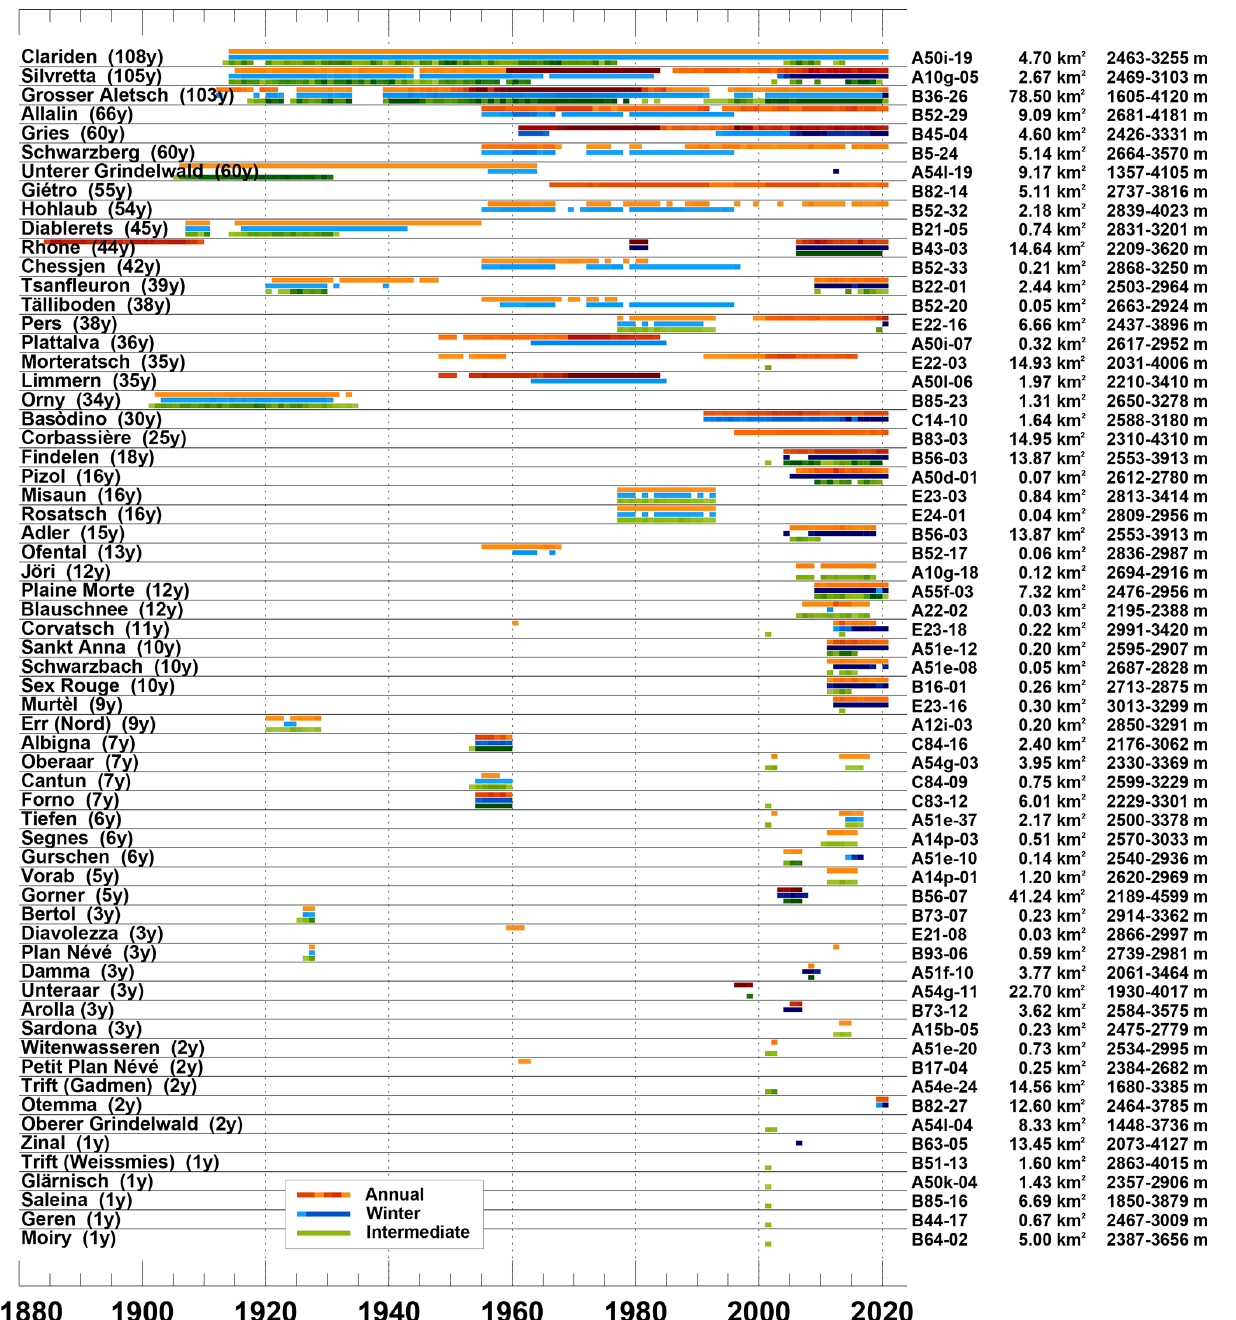
Figure 6. Overview of the temporal coverage of point mass balance series for the annual period (orange–red), the winter period (light–dark blue), and intermediate periods (light–dark green). Light colours qualitatively indicate that few data per year are available and dark colours refer to a high number of point measurements. Glaciers are ordered according to the total length of the period covered by measurements (given in parenthesis). On the right, the identifier according to the latest Swiss glacier inventory (Linsbauer et al., 2021) and the corresponding area and elevation range is given for characterizing the